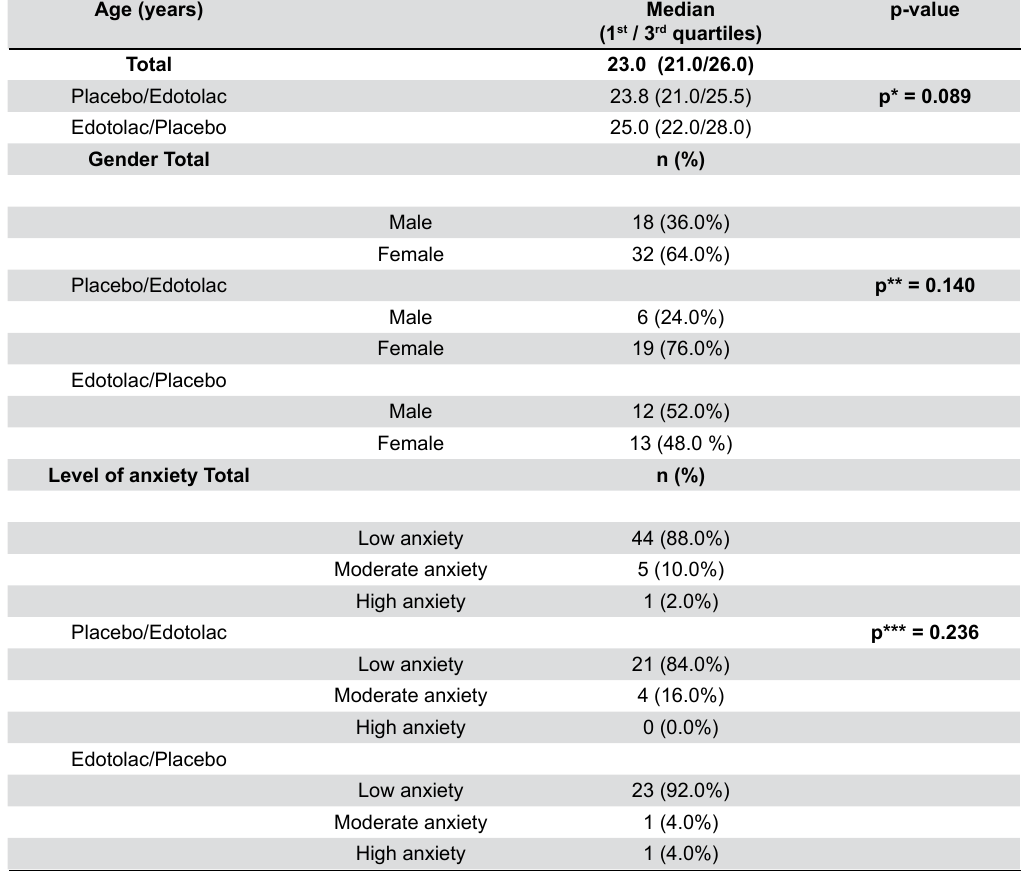
Table 1- Profile of patients included in the study allocated to each sequence of treatment